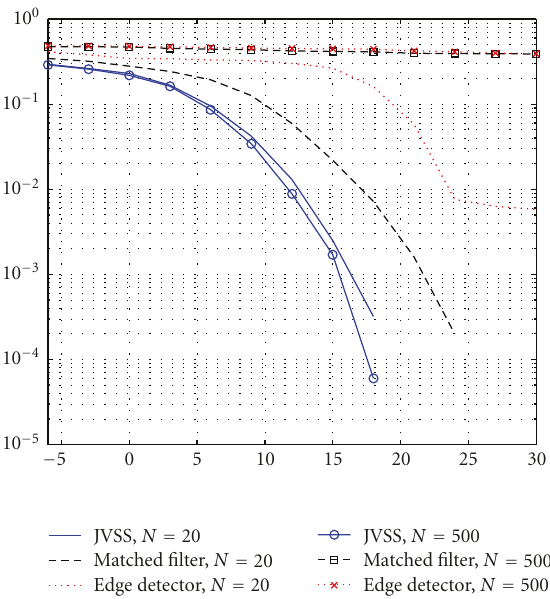
Figure 6: Comparisons of the BERs of the proposed algorithm with regular data